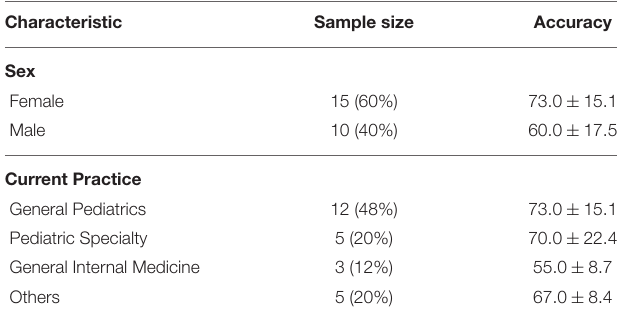
TABLE 4 | Clinician demographics and corresponding accuracy (mean% and SD%) by groups.